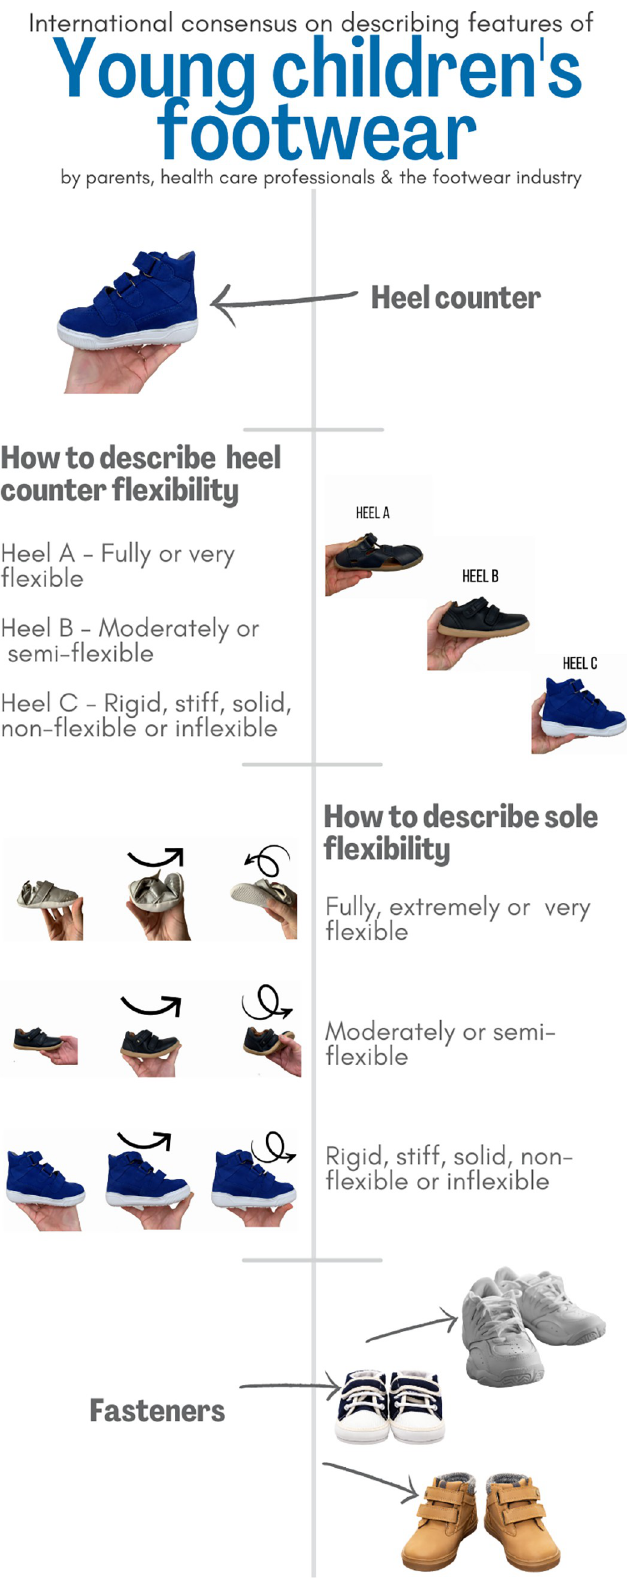
Fig 5. Footwear feature definitions